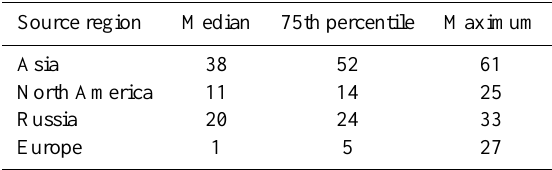
Table 4. Statistics pertaining to the number of long range transport events recorded over all verification stations over a